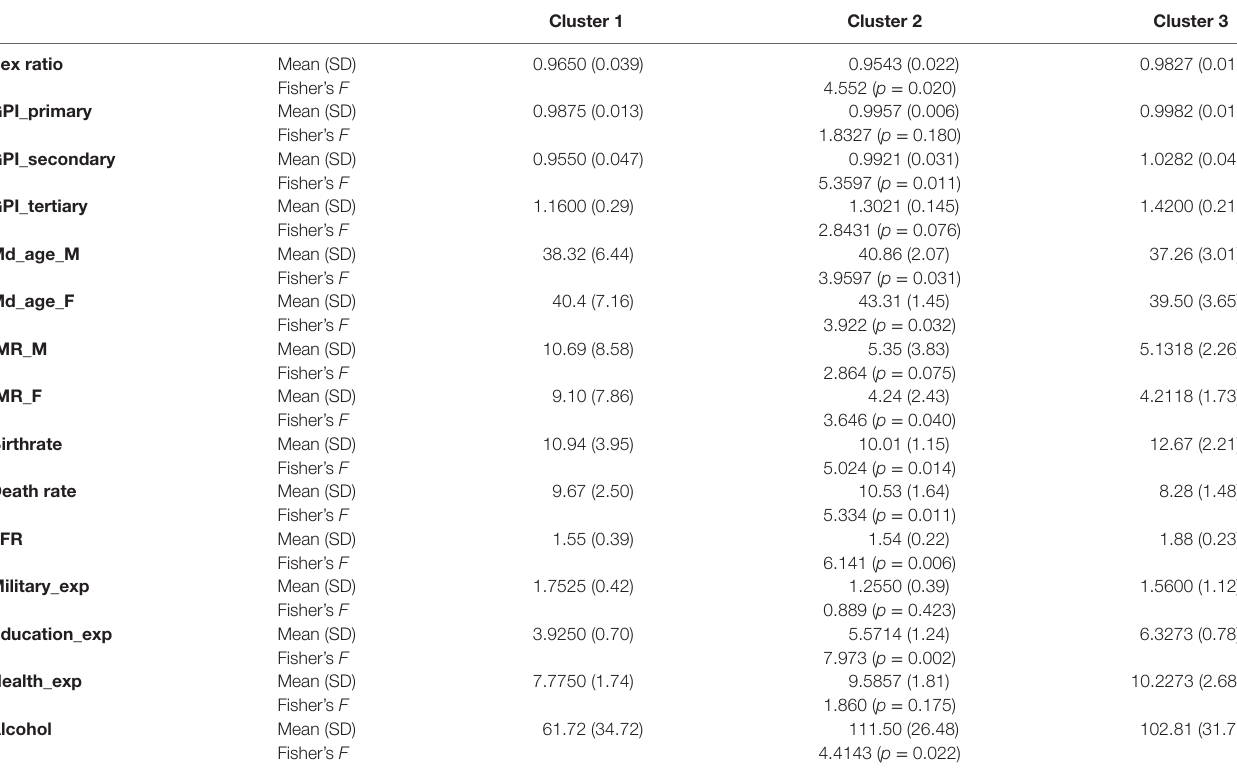
tabLe 3 | demographic variables in each